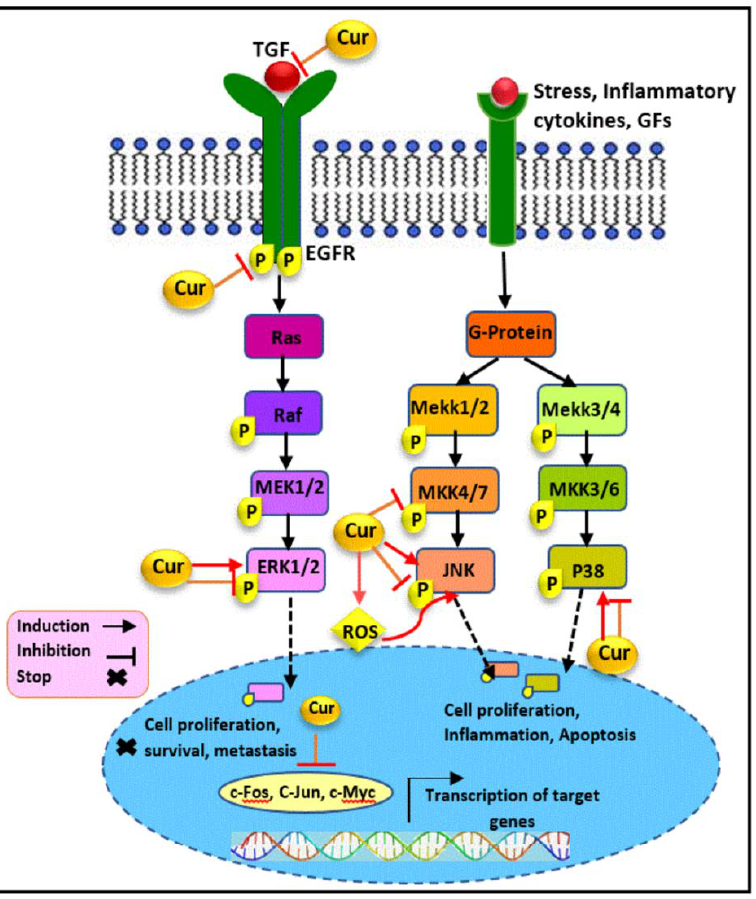
Figure 3. The modulatory effect of curcumin on the MAPK pathway. Curcumin exerts its anticancer activity through the modulation of key components involved in the MAPK signaling pathway. Cur- cumin targets TGF, EGFR, ERK1/2, MKK4/7, JNK, and P38 molecules and downregulates the ex- pression level of nuclear c-Myc, c-Fos, and c-Jun as the downstream targets of the MAPK pathway, which results in the inhibition of cellular proliferation and migration as well as apoptosis induction in hormone receptor negative breast cancer. Cur: curcumin, G-protein: guanine nucleotide-binding protein, TGF: transforming growth factor, GFs: growth factors, EGFR: epidermal growth factor re- ceptor, Raf: rapidly accelerated fibrosarcoma, MAPK: mitogen-activated protein kinase, ERK: extra-